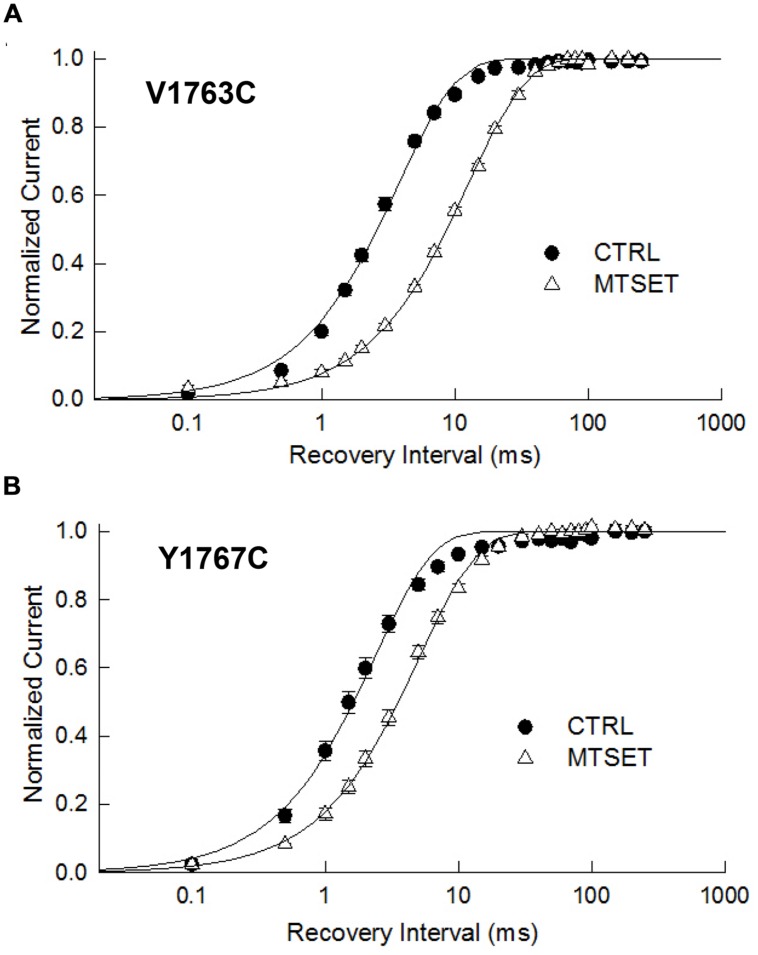
Methanethiosulfonate reagent slows recovery from inactivation. Depolarizing prepulses to –10 mV for 20 ms were used to the V1763C (A) and Y1767C (B) mutant channels. Cells were returned to –140 mV for a variable interval (0.1 ms–250 ms) before applying a standard test pulse to –10 mV for 20 ms. The test currents were normalized to the recovery measured after 250 ms of recovery and plotted versus the recovery interval. The smooth lines are biexponential curve fits with time constants and relative amplitudes of the fast components listed in Table 1.